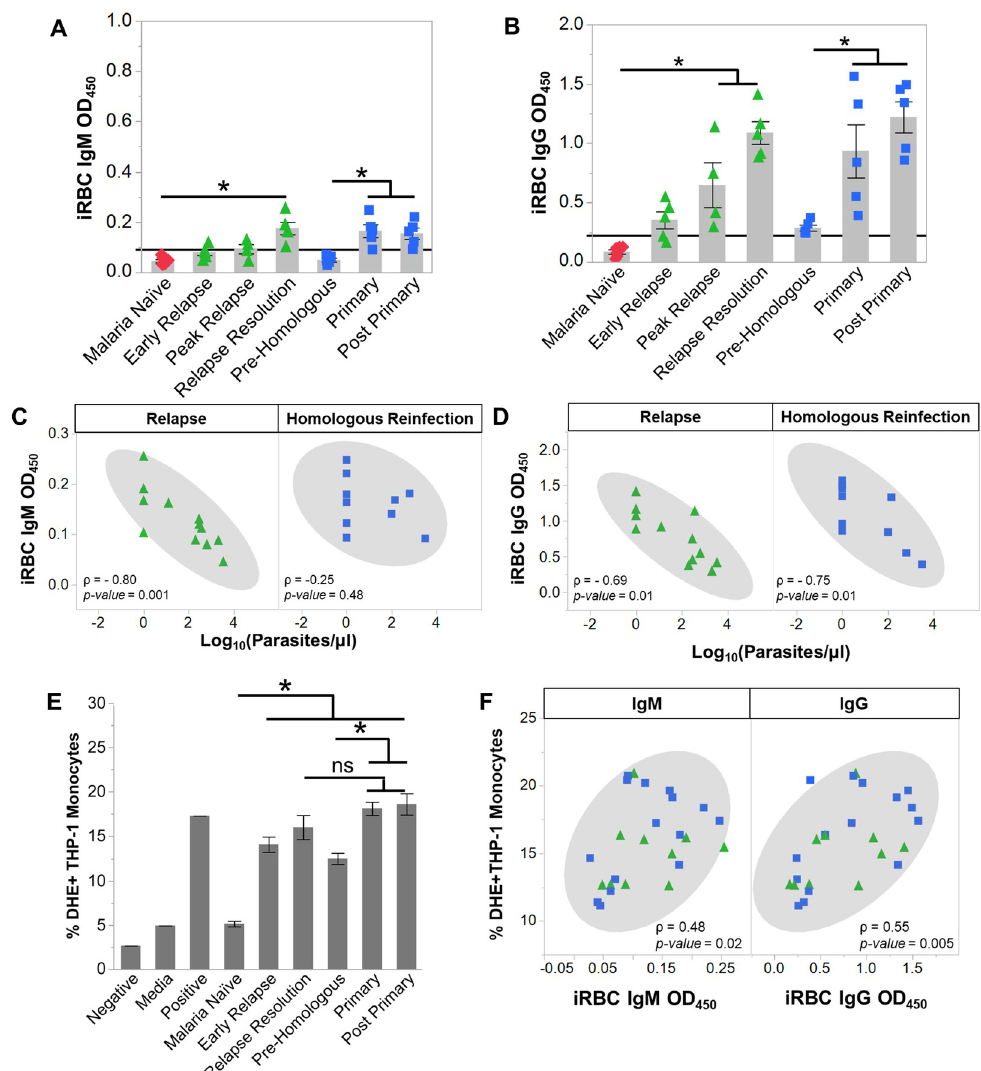
determined by ELISA; the black line indicates background defined as the average of the malaria na ï ve time point plus three standard deviations. Spearman’s correlation analysis of anti-iRBC IgM (c) and anti-iRBC IgG (d) responses in relation to parasitemia during relapses and homologous reinfections. (e) Percentage of THP-1 monocytes that phagocytosed P . cynomolgi M/B strain iRBCs after opsonization with heat-inactivated plasma collected at different infection points during relapses homologous reinfections. (f) Spearman’s correlation analysis of opsonic phagocytosis activity and anti-iRBC IgM and IgG during relapses and homologous reinfections. Gray bars indicate the mean of the data points shown; Error Bars = SEM. Statistical significance was assessed by a linear mixed effect model using a Tukey-Kramer HSD post-hoc analysis. Asterisks indicate a p-value < 0.05. ρ = Spearman’s correlation